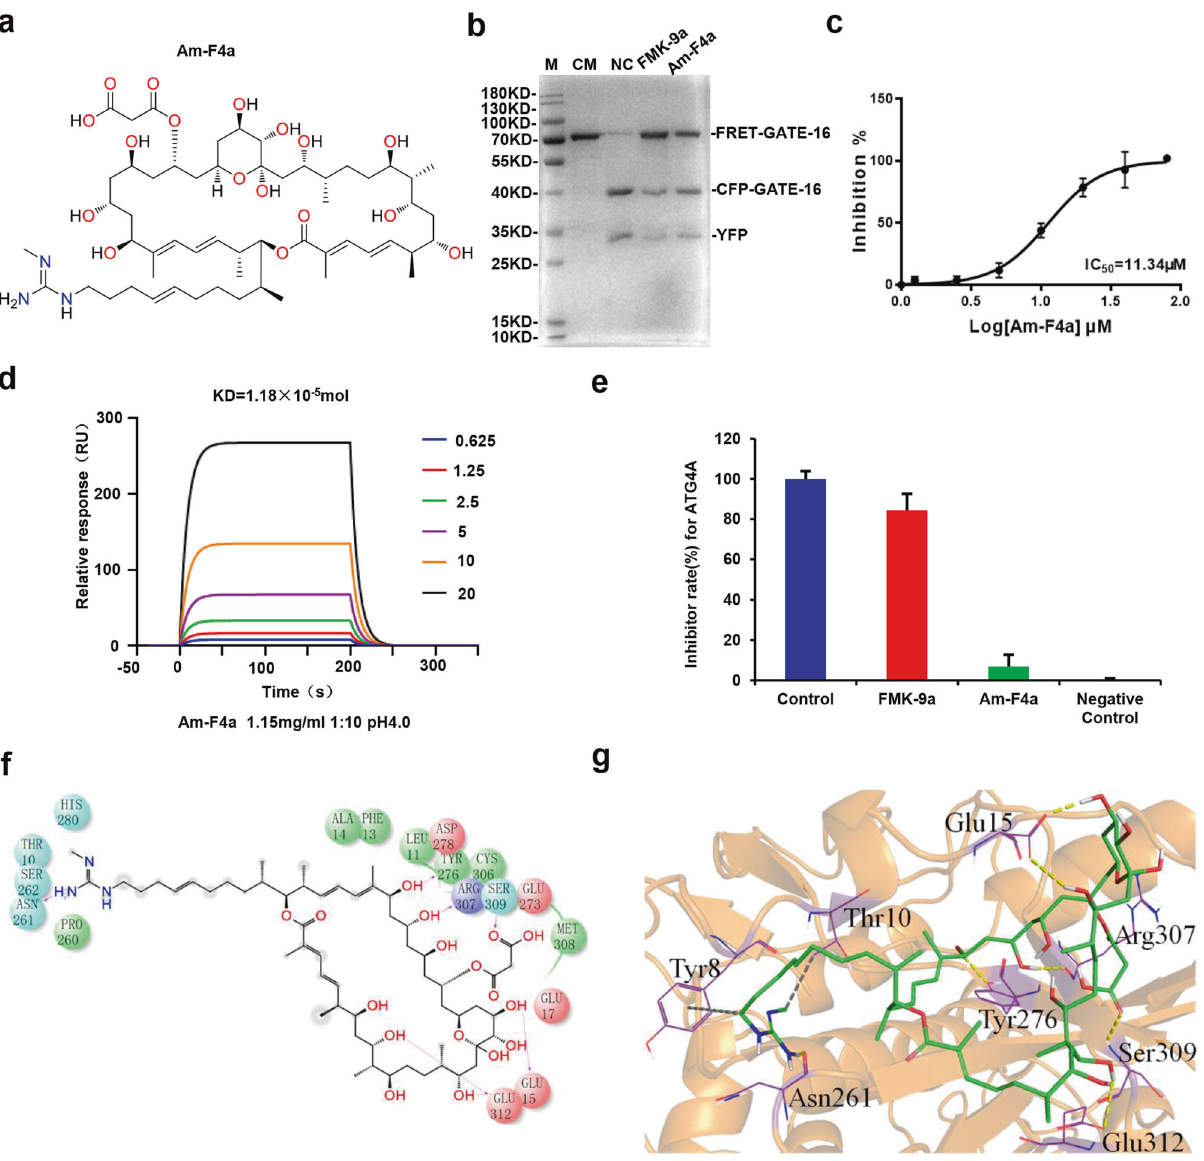
Fig. 2 Identi fi cation of Am-F4a as a novel ATG4B inhibitor. a Chemical structure of Am-F4a. b ATG4B (0.75 μ g/mL) was incubated with or without Am-F4a (10 μ M) at 37 °C for 30 min, FRET-GATE-16 was then added and incubated at 37 °C for another 30 min. The inhibitory effect of Am-F4a was detected by SDS-PAGE according to the cleavage of FRET substrates. FMK-9a was used as a positive control. c The inhibitory effect and IC50 of Am-F4a on ATG4B activity were obtained from FRET assay. d Surface plasmon resonance (SPR) analysis of binding af fi nity of Am- F4a to ATG4B. The K d value was calculated based on the fi tted curves. e Am-F4a on ATG4A activity, the inhibitory effect of Am-F4a was detected by FREAT. f , g The predicted 2D and 3D binding mode of Am-F4a with ATG4B by molecular docking. In 3D mode, the protein and ligand Am-F4a are shown by cartoon and stick respectively, the highlighted interacting residues are shown by lines, the hydrogen bonds are labeled by yellow dashed lines, and the hydrophobic interaction are labeled by gray dashed